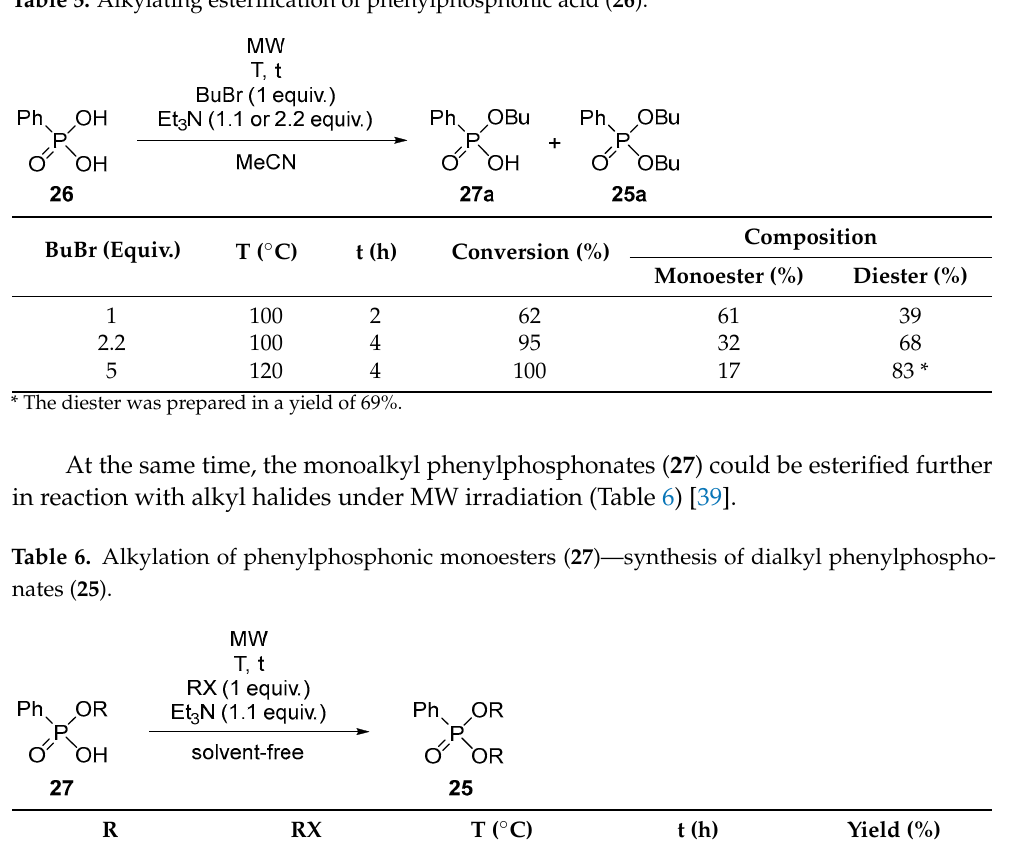
Table 5. Alkylating esterification of phenylphosphonic acid ( 26 ).